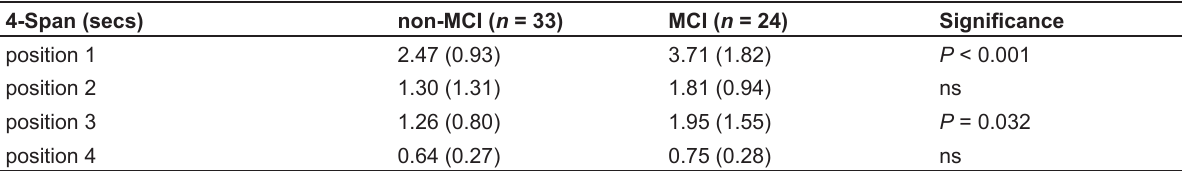
Table 4. Symbolic working memory—latency for serial order